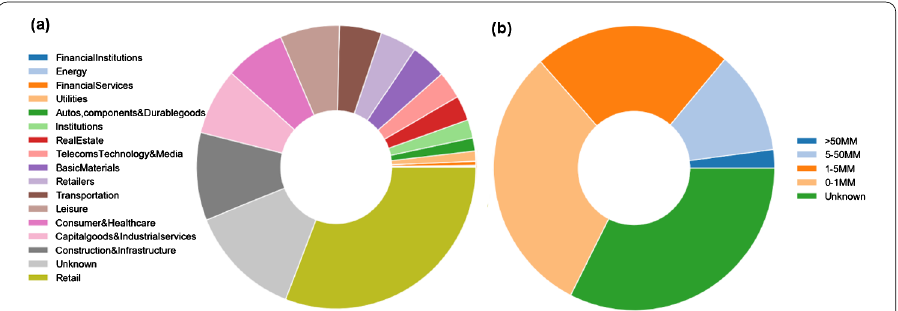
Figure 1 Sectorandannualrevenuedistributionofthecustomer-suppliernetwork . Distribution of the customer-supplier network by sector and annual revenue. Firms can be classified in 17 sectors according to their NACE code (NACE (Nomenclature of Economic Activities) code is the European statistical classification of economic activities) and main economic activity. Besides, firms can be also classified according to their annual revenue: micro-SME’s (less than 1MM EUR, small (1–5MM EUR), SME’s (5–50MM EUR) and large (more than 50MM